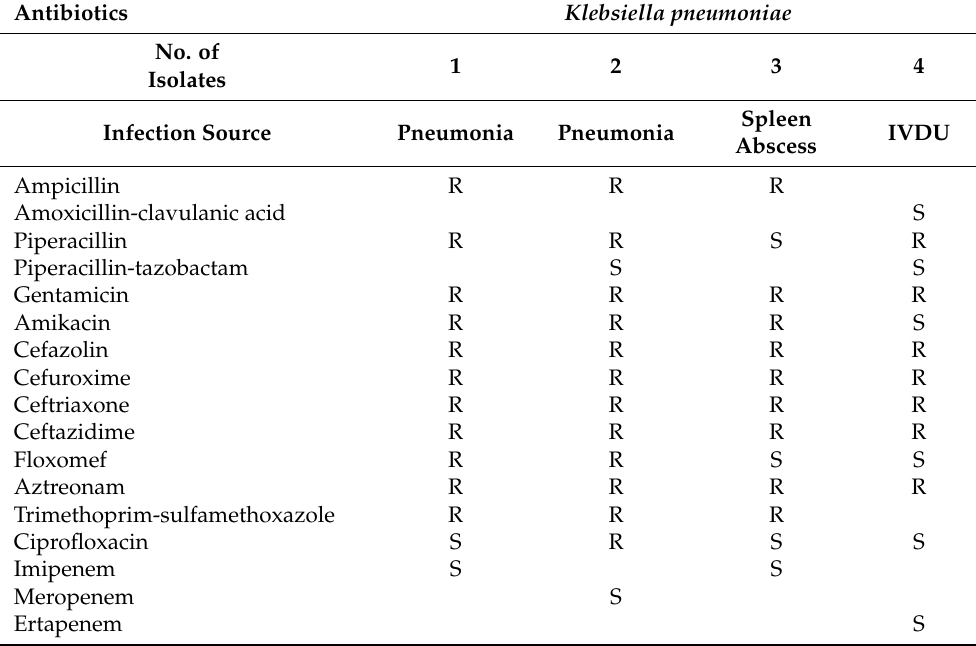
Table 4. Antibiotic susceptibility testing in multidrug-resistant Klebsiella pneumoniae .